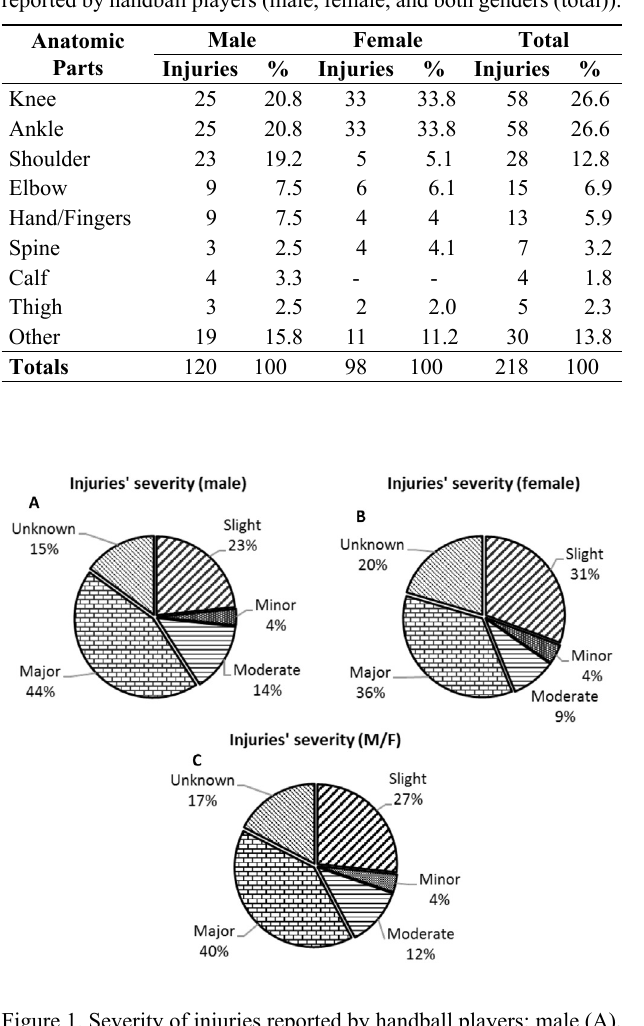
Figure 1. Severity of injuries reported by handball players: male (A), female (B), and both genders (C).